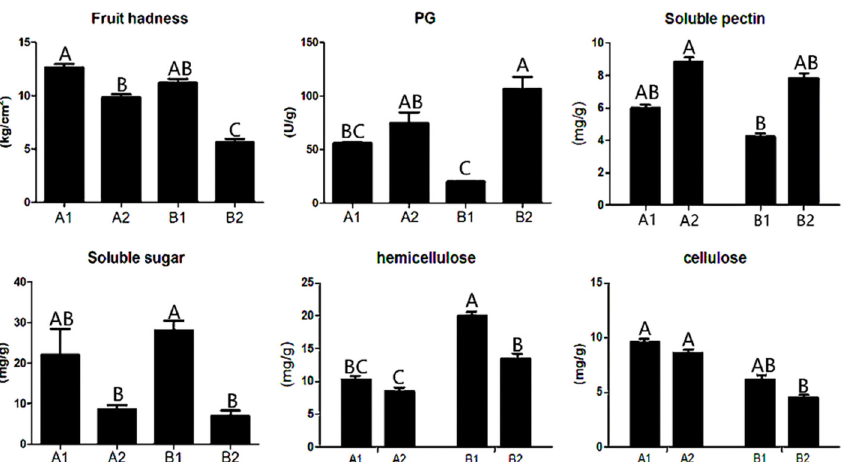
Figure 1. Physiological indexes of pepper before and after storage. Annotation: The abscissa represents different groups; the ordinate represents the content. A1 represents A144 material stored for 0 days; A2 represents A144 material stored for 3 days; B1 represents A361 material stored for 0 days; B2 represents A361 material stored for 3 days. Different letters above the bar chart indicate significant differences ( p <